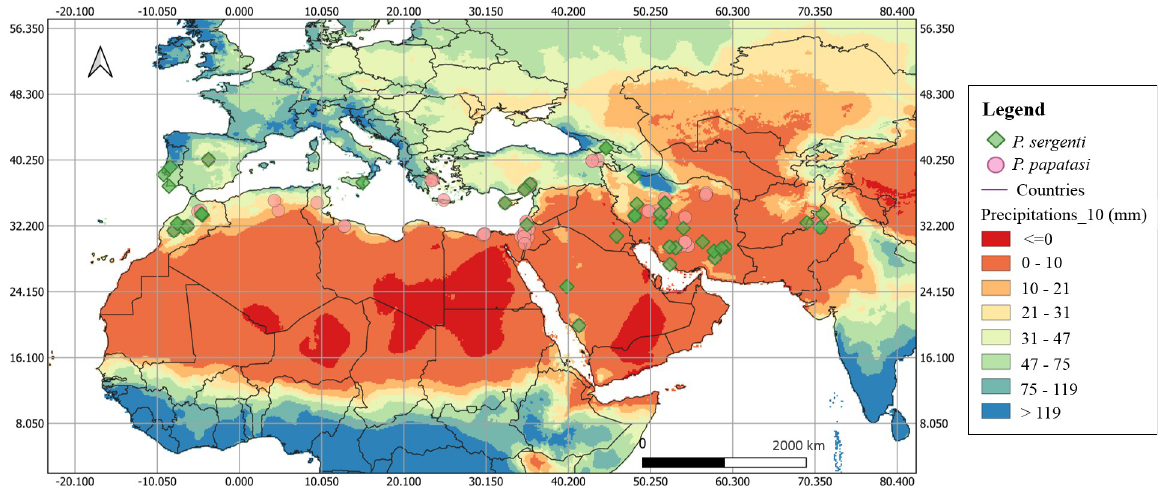
Fig 2. The geographic location where data on P . (Par . ) sergenti are published. Sites with data on the seasonal density of P (Par . ) . sergenti and the annual precipitation (mm). Phlebotomus ( Phlebotomus ) papatasi geographic distribution data were extracted in a previously published work [55]. Precipitation data were collected at ESRI grids, resolution 10 min according to WorldClim 1.4 (current conditions), http://worldclim.com/ current; [56]). Boundaries were adapted and modified from Open Data Soft https://public.opendatasoft.com/explore/dataset/world- administrative-boundaries/export/.